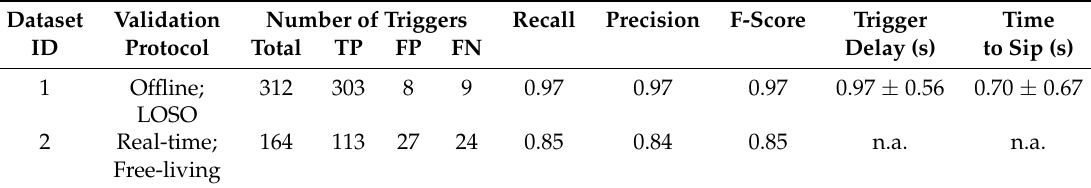
Table 2. Drink trigger detection results. LOSO: